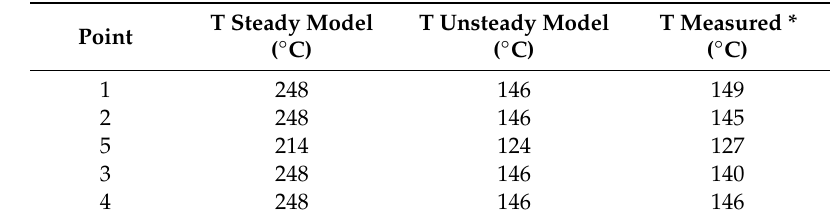
Table 2. Comparison of modeled and measured temperatures at the final stage of the fire test (60 min in the measuring points required by the International Code for the Application of Fire Test Procedures (2010 FTP Code) (Figure 1b). Ambient temperature equal to 28 ◦ C in this study.